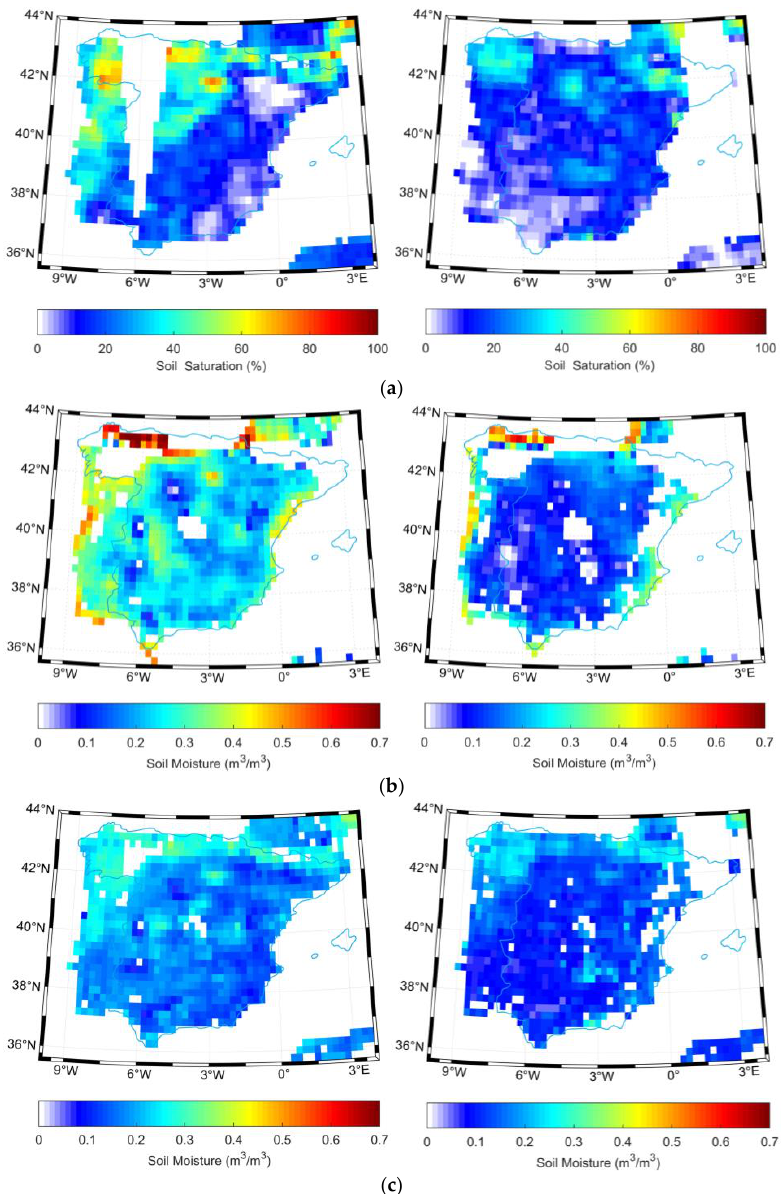
Figure 7. Extracted soil moisture retrieved from ( a ) active ( b ) passive ( c ) combined microwave data over Spain on 15 April (left) and 27 July (right) 2014. Sensors 2019 , 19 , x FOR PEER REVIEW